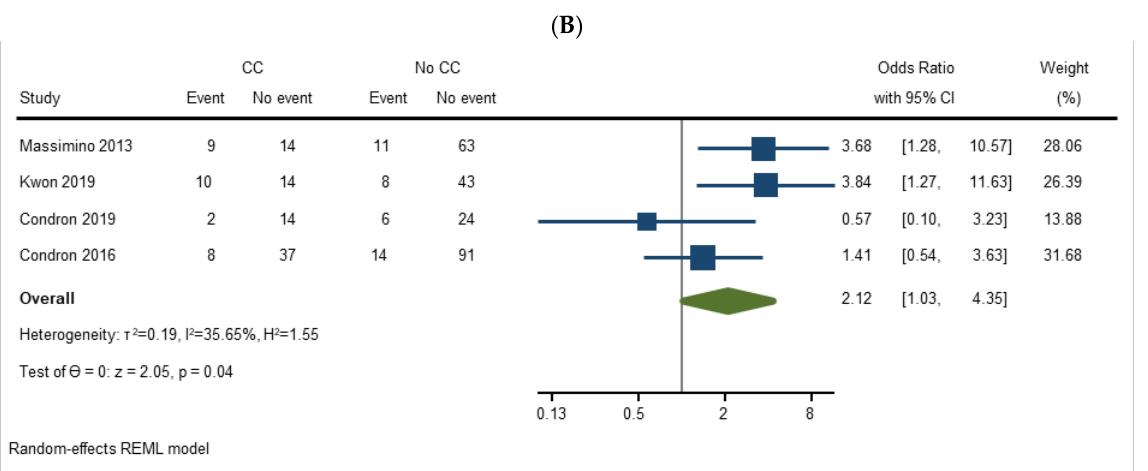
Figure 4. ( A ) Forest plot evaluating prognosis of carcinoid crisis — postoperative mortality; ( B ) For- ( A ) Forest plot evaluating prognosis of carcinoid crisis—postoperative mortality; est plot evaluating prognosis of carcinoid crisis — any postoperative complication; ( C ) Forest plot ( B ) Forest plot evaluating prognosis of carcinoid crisis—any postoperative complication; ( C ) Forest evaluating prognosis of carcinoid crisis — major postoperative complication [21,22,24,26,27]. plot evaluating prognosis of carcinoid crisis—major postoperative complication [21,22,24,26,27].